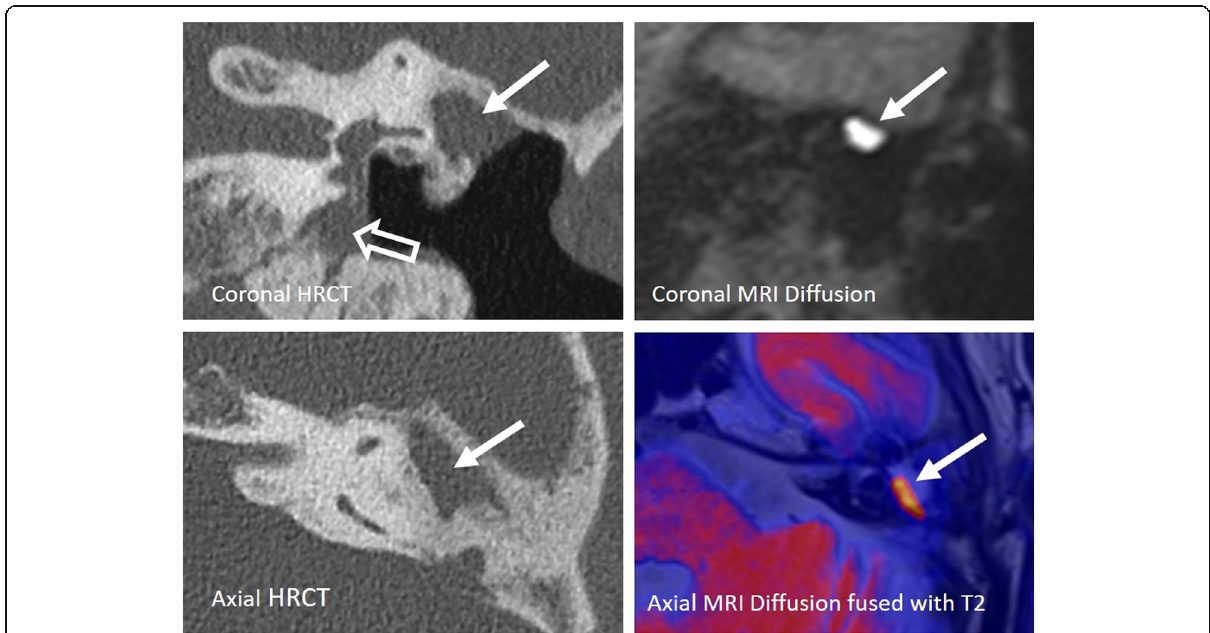
Fig. 17 A 80-year-old male patient, with severe SNHL enrolled for cochlear implant surgery. The patient had chronic middle ear infections and cholesteatoma surgery with tympanoplasty type IV several years ago. HRCT coronal and axial images (left images) show opacified antrum (arrow) and opacified hypotympanon (open arrow). A recurrent cholesteatoma cannot be ruled out. Corresponding MRI diffusion coronal image and color-coded axial image fused with T2 (right images) show a high signal intensity in the opacified antrum, typical for cholesteatoma (arrow). The diagnosis was surgically verified, and the patient successfully received a CI one month after revision surgery